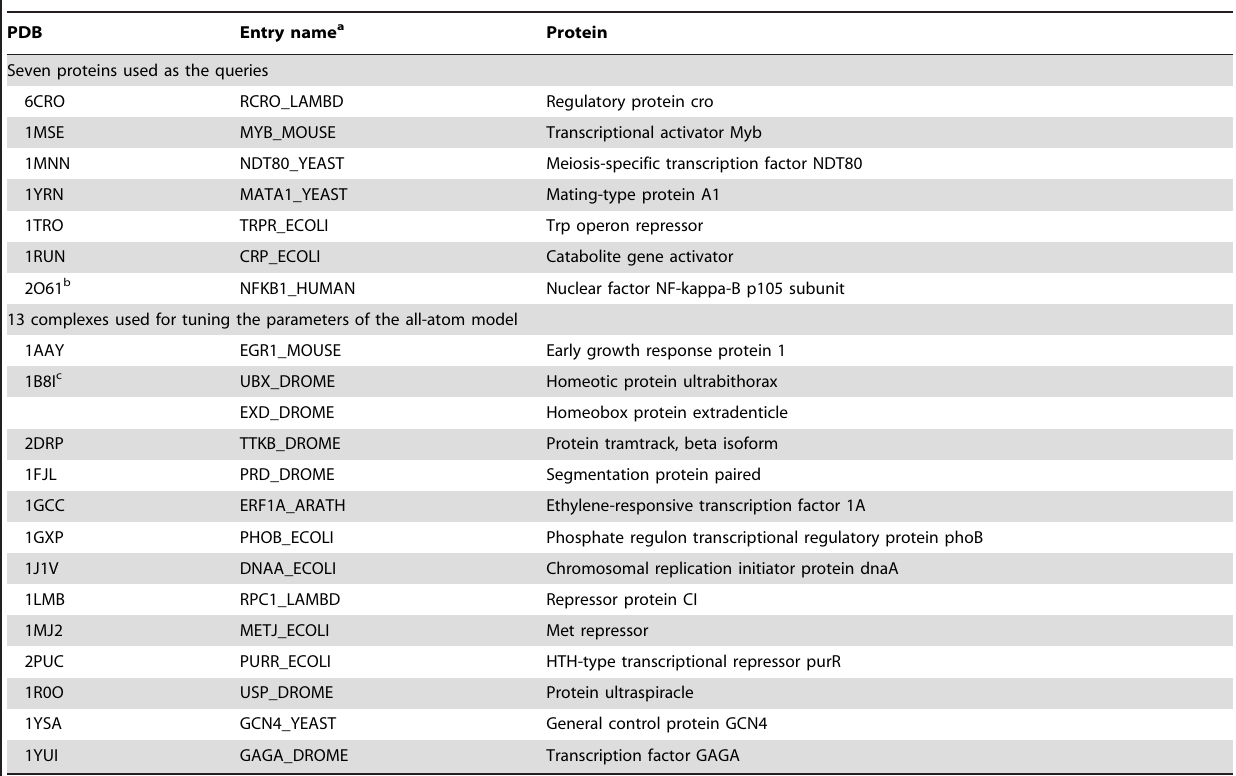
Table 1. The validation set used in this